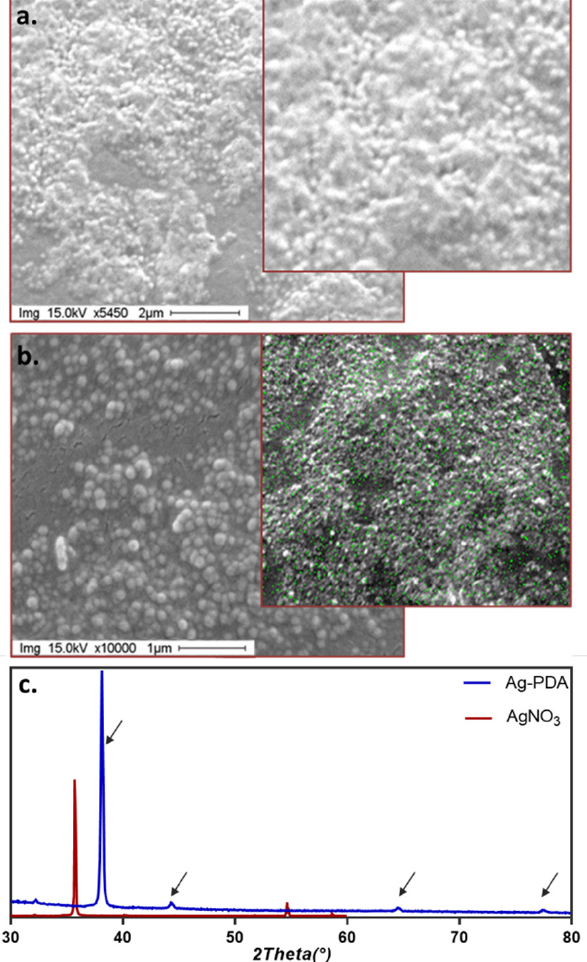
Figure 4. ( a ) SEM image of the first fraction ( b ) SEM image of the second fraction. Inset: EDX map. ( c ): X-rays diffraction patterns of the second fraction (blue line) collected (arrows: typical reflections of nanoAg), superimposed on the AgNO 3 pattern as a control (red